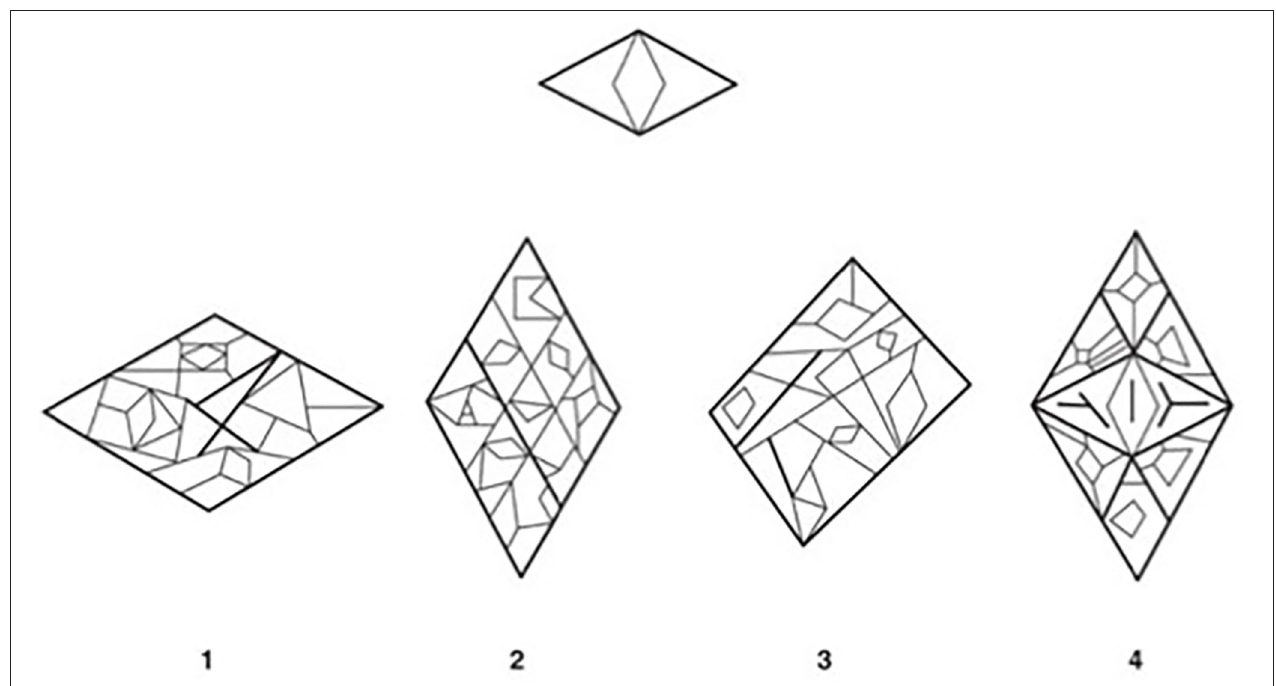
FIGURE 1 | Example item from the Figure-Ground subtest of the TVPS-3. Participants are asked to find a simple image, or a design (top) nested within one of four more complex shapes (bottom). Correct answer in the above example: 4. The example TVPS-3 item illustrated above (Martin and Gardner, 2006) has been reproduced with permission from Academic Therapy